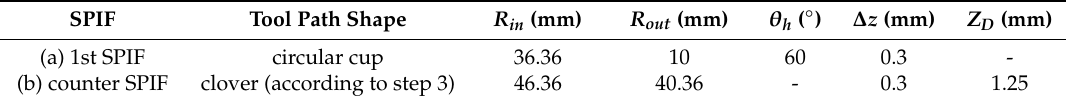
Table 3. Final experimental conditions of (a) the 1st and (b) the counter SPIF.